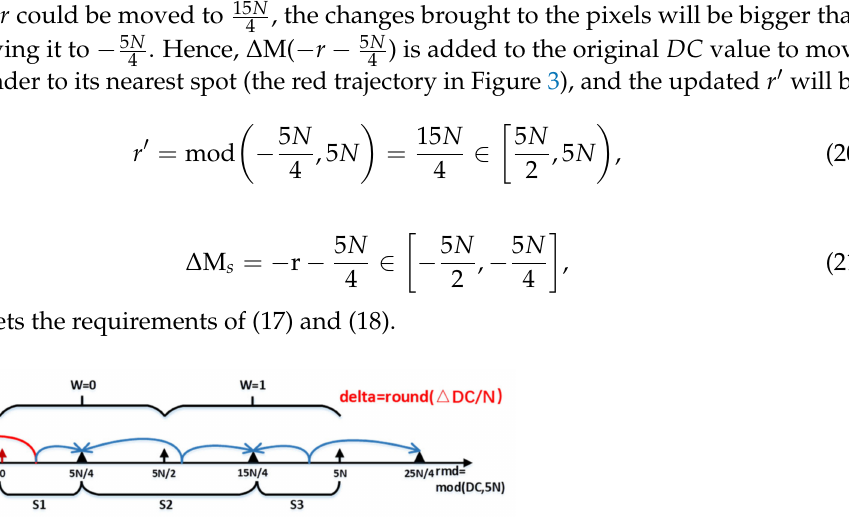
Figure 3. Dividing the range of r into three sections and modifying the DC component according to the principle of